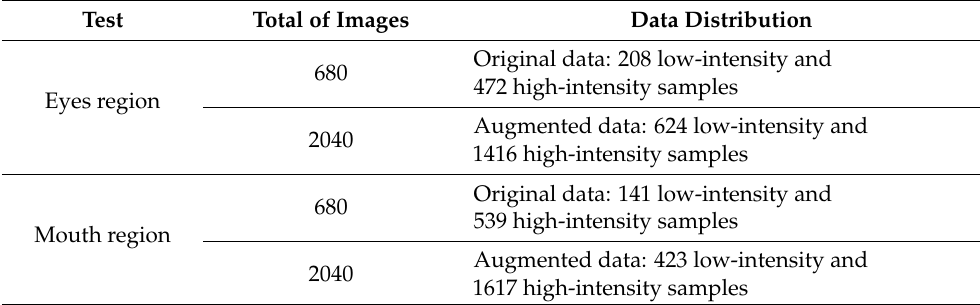
Table 6. Data distribution for the prediction of two palsy